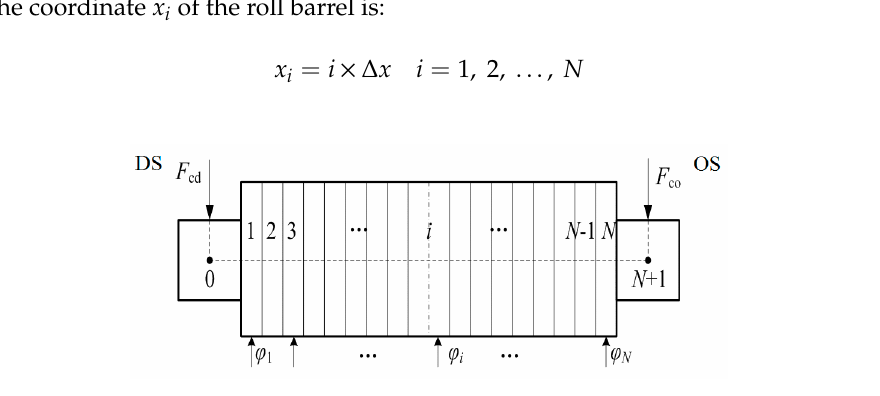
Figure 4. Discretisation of the back ‐ up roll and loads.